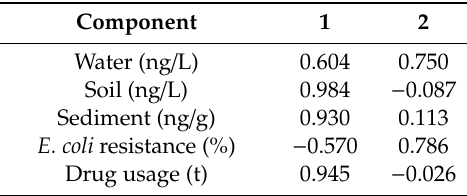
Table 4. The component matrix of relevant antibiotic data in Chongqing,